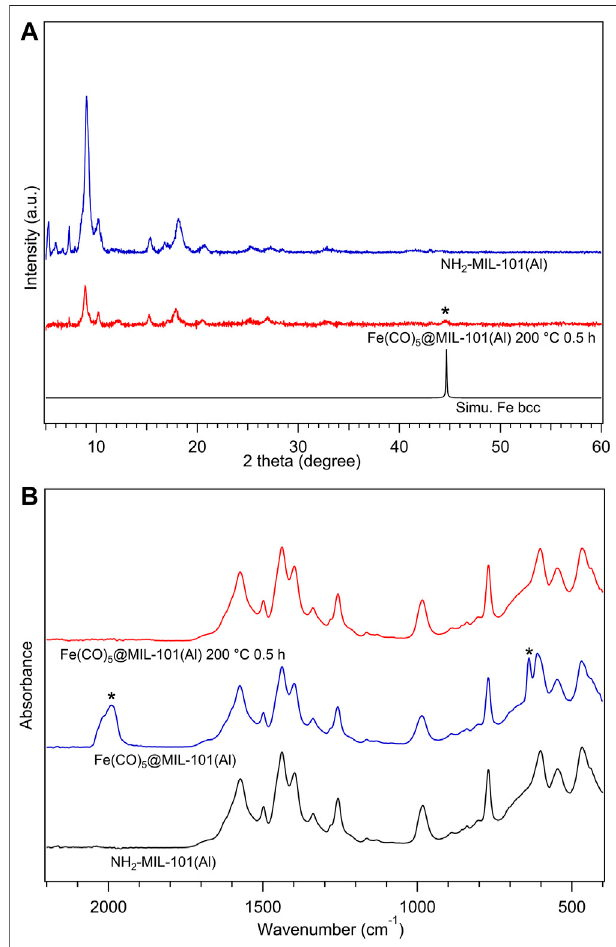
FIGURE 5 | (A) Infrared spectra for activated NH 2 -MIL-101(Al) (black), Fe(CO) 5 @MIL-101(Al) (blue), and Fe(CO) 5 @MIL-101(Al) decomposed at 200 ° C/0.5 h (red), all samples were measured inside a glovebox. (B) XRPD patterns of NH 2 -MIL-101(Al) (blue), Fe(CO) 5 @MIL-101(Al) decomposed at 200 ° C/0.5 h (red), and simulated body-centred-cubic Fe (black), all samples were measured under inert conditions by capillary technique. The radiation wavelength was 1.5406